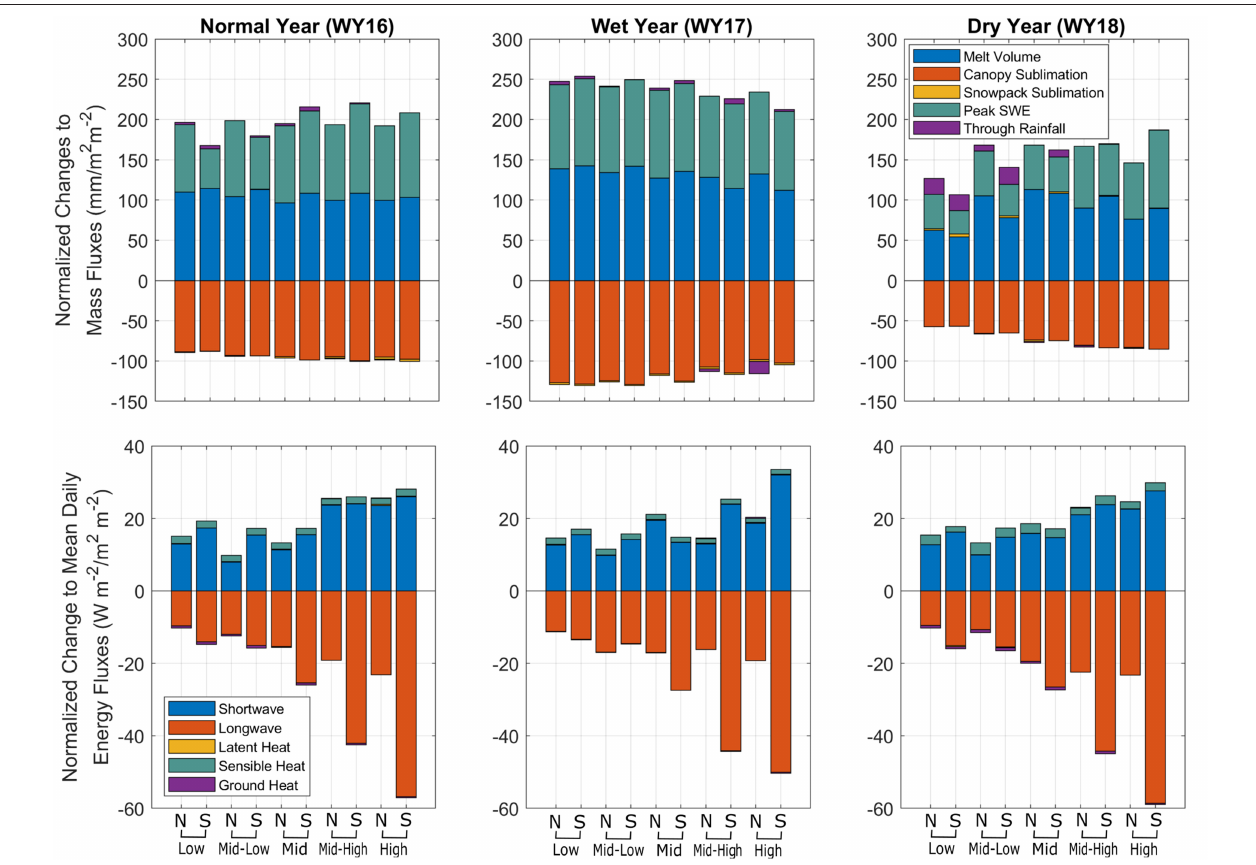
FIGURE 8 | Upper panels: changes to the mean total mass fluxes normalized by LAI changes between the thinning scenarios and the control run. Lower panels: changes to the mean daily energy fluxes normalized by LAI changes. Values from both thinning scenarios are used.